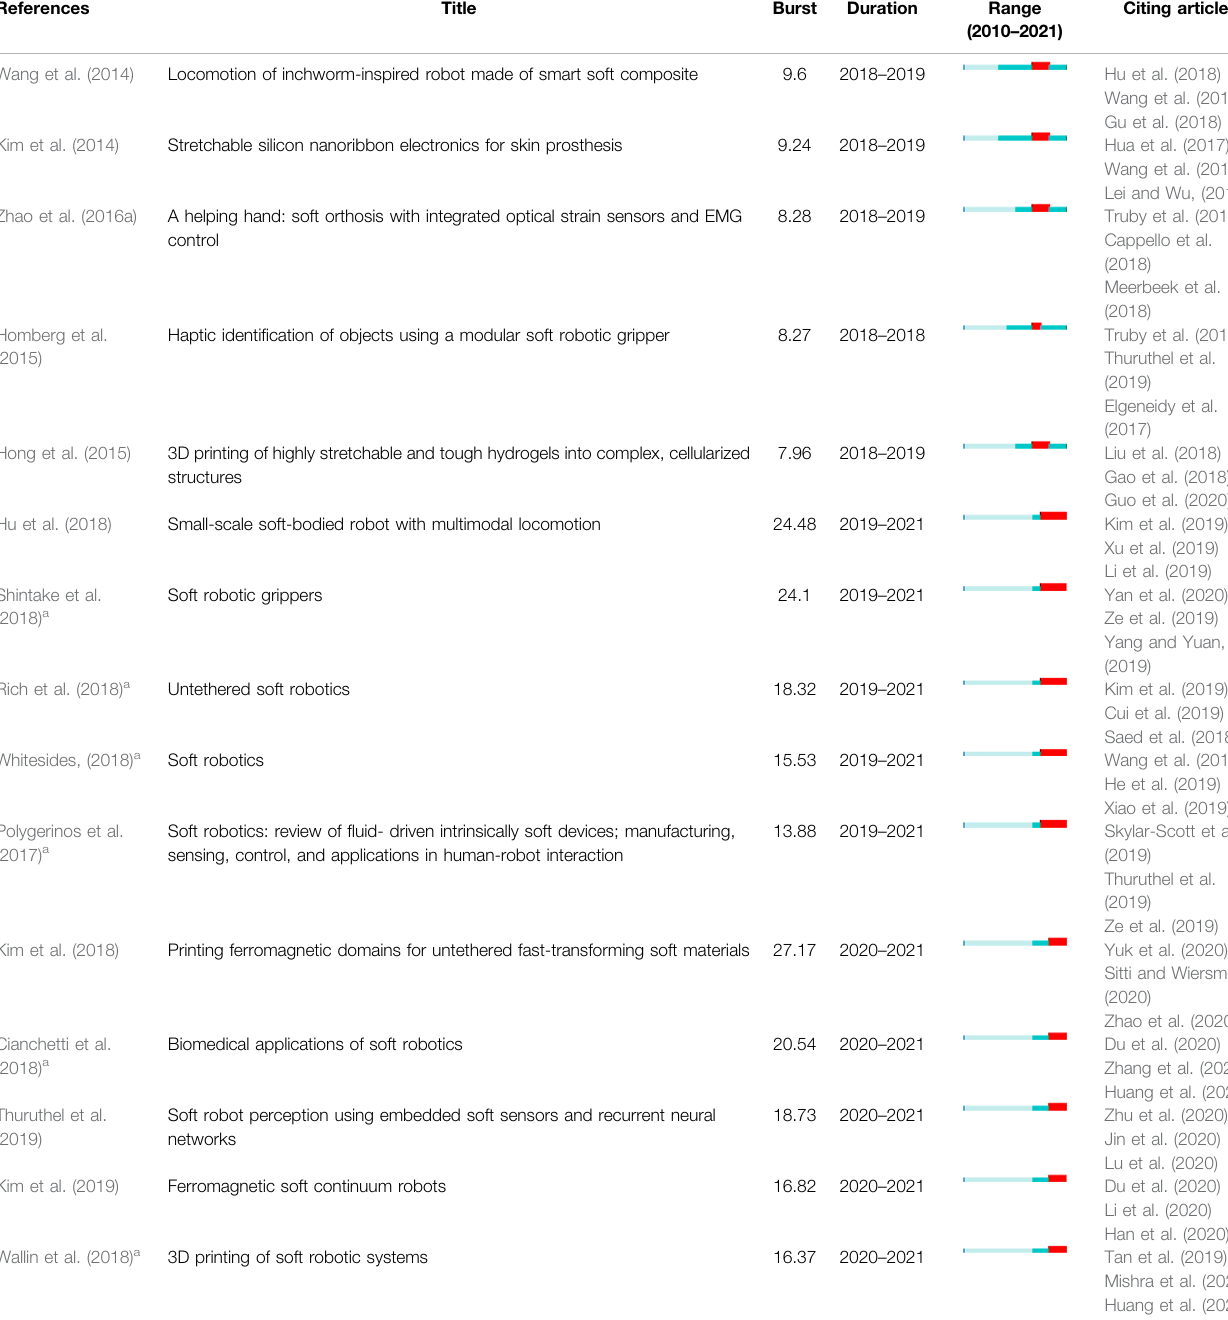
TABLE 8 | The top 5 references with the strongest citation bursts starting 2018, 2019, and 2020,